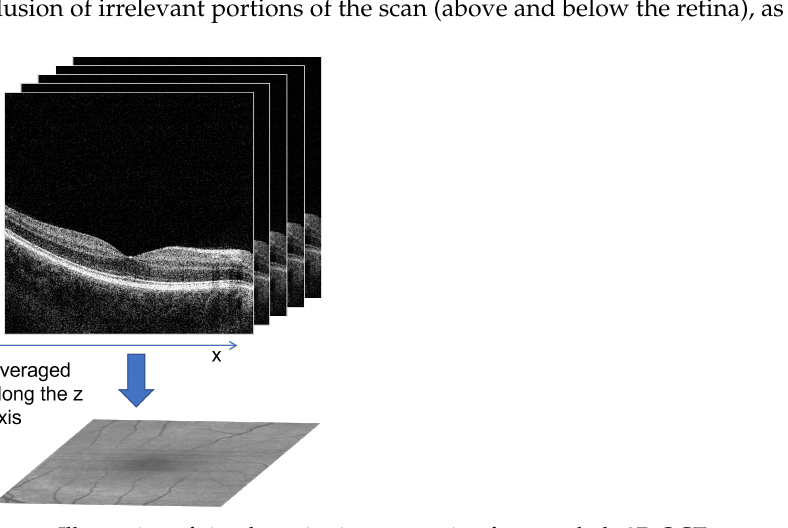
Figure 1. Illustration of simple projection generation from a whole 3D OCT